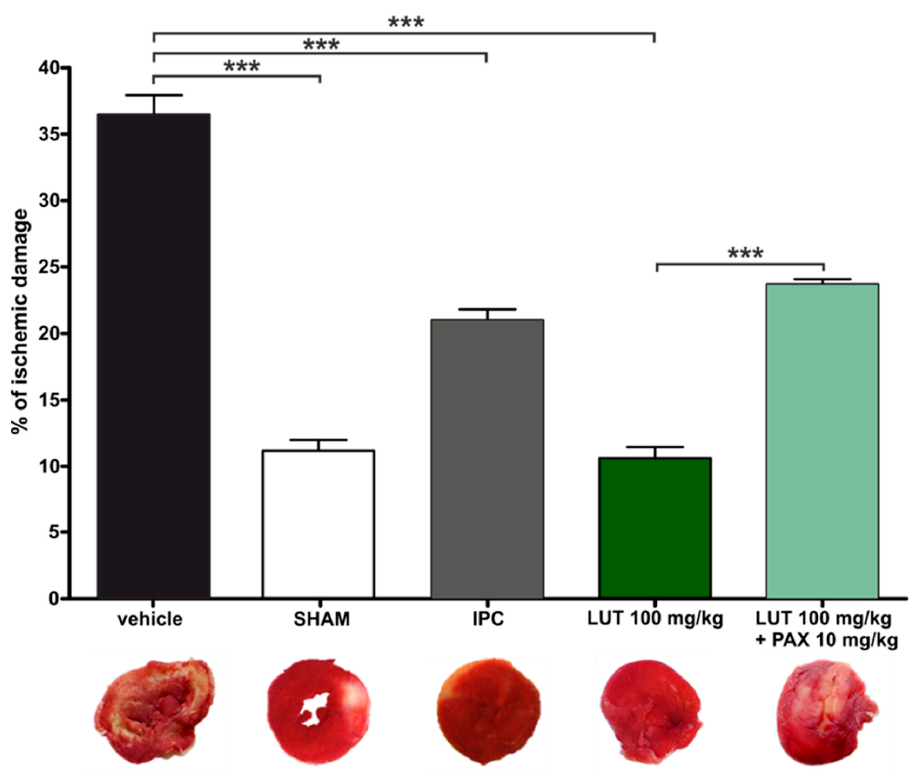
Figure 1. Morphometric quantification of ischemia/reperfusion-induced injury observed in ventricular slices of rat hearts, after acute myocardial infarction in vivo. Graph shows % of ischemic damage in comparison to whole slice area for vehicle (3 mL/kg DMSO), SHAM, IPC and after treatment with LUT (100 mg/kg) and LUT with paxilline (100 mg/kg + 10 mg/kg). Additionally, the figure shows exemplary photographs of cross-sections through the left ventricle with a stained ischemic zone in the given experimental conditions. The level of statistical significance was determined by one-way ANOVA with Tukey post hoc test, n = 3, p < 0.001